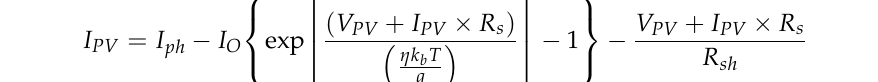
Figure 1. Electrical equivalent diagram for single diode PV model.